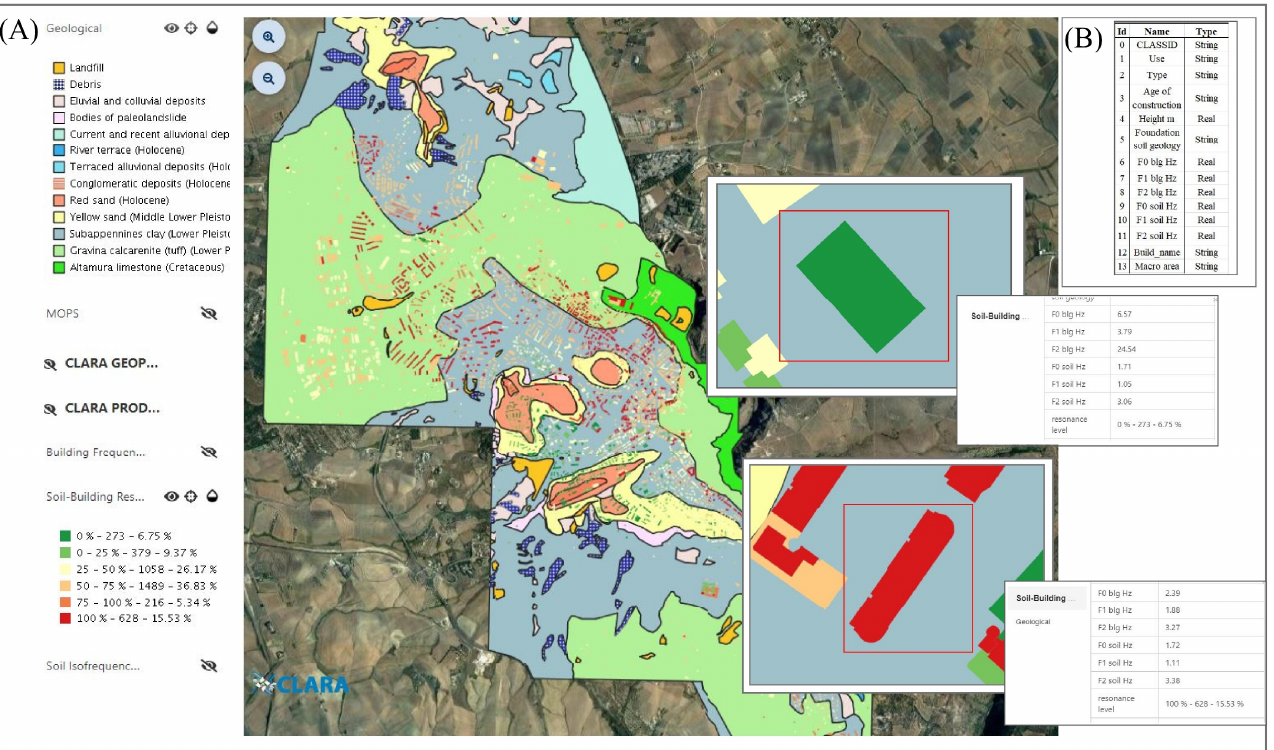
Figure 12. ( A ) Screenshot of soil–building resonance levels overlapping the geological map in the urban area of Matera. The insets show two examples: a (red-colored) building having ‘F1 blg Hz’ and ‘F2 blg Hz’ values included in the interpolated soil frequency range (100% probability of resonance occurrence), and a (green-colored) building with a probability of resonance effect equal to 0%, along with the related pop-up windows; ( B ) attribute table of soil-building resonance level layer.